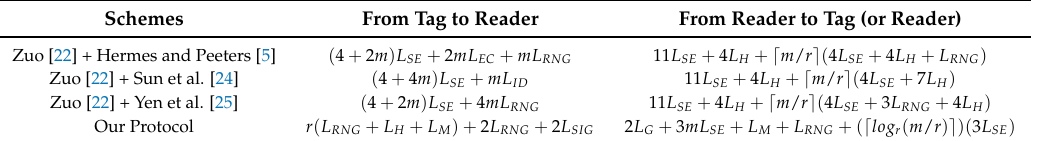
Table 6. Transmission capacity.